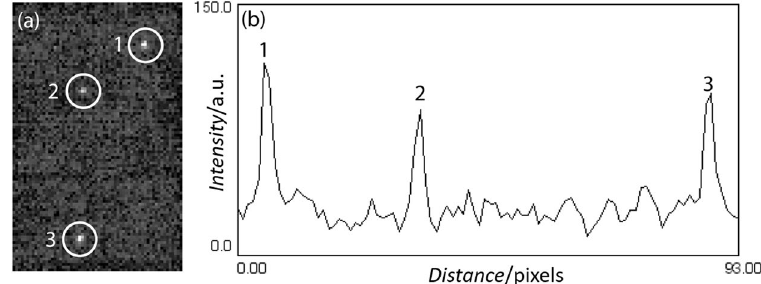
Figure 6. ( a ) Wide field fluorescence of one selected frame (frame no. 282) from the movie (see Supporting, M1. UCNP in sucrose) with NP-UCNPs in 50% sucrose showing 3 particles (1 to 3). ( b ) Corresponding positional time trace of the selected particles. Particles 1 and 2 were considered for fluorescence intensity autocorrelation